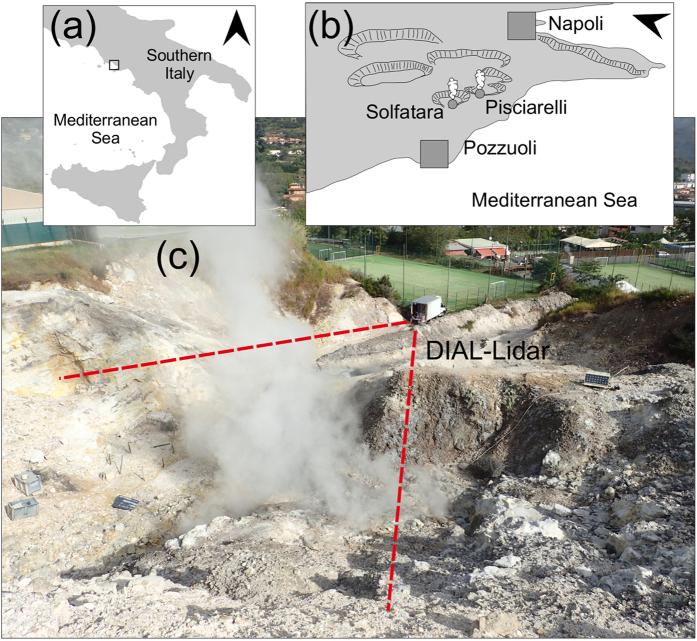
(a) A sketch map (created with LibreOffice) of Southern Italy, showing the location of Campi Flegrei caldera (b); (c) The Pisciarelli fumarolic field, with the DIAL in the background (photo of C. Minopoli).